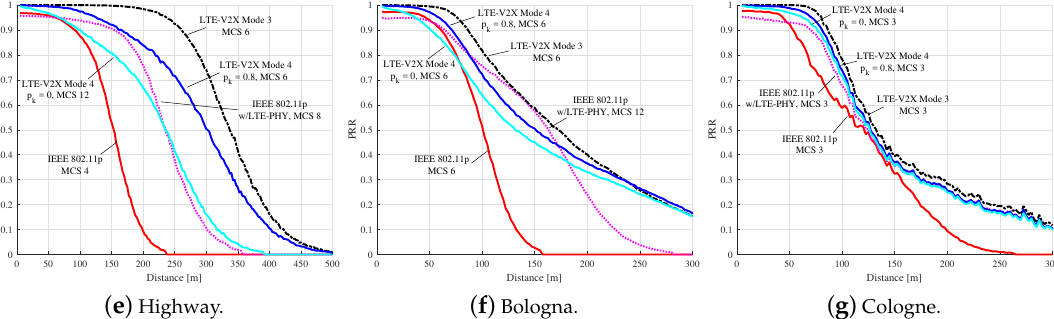
Figure 6. Packet reception ratio vs. distance.